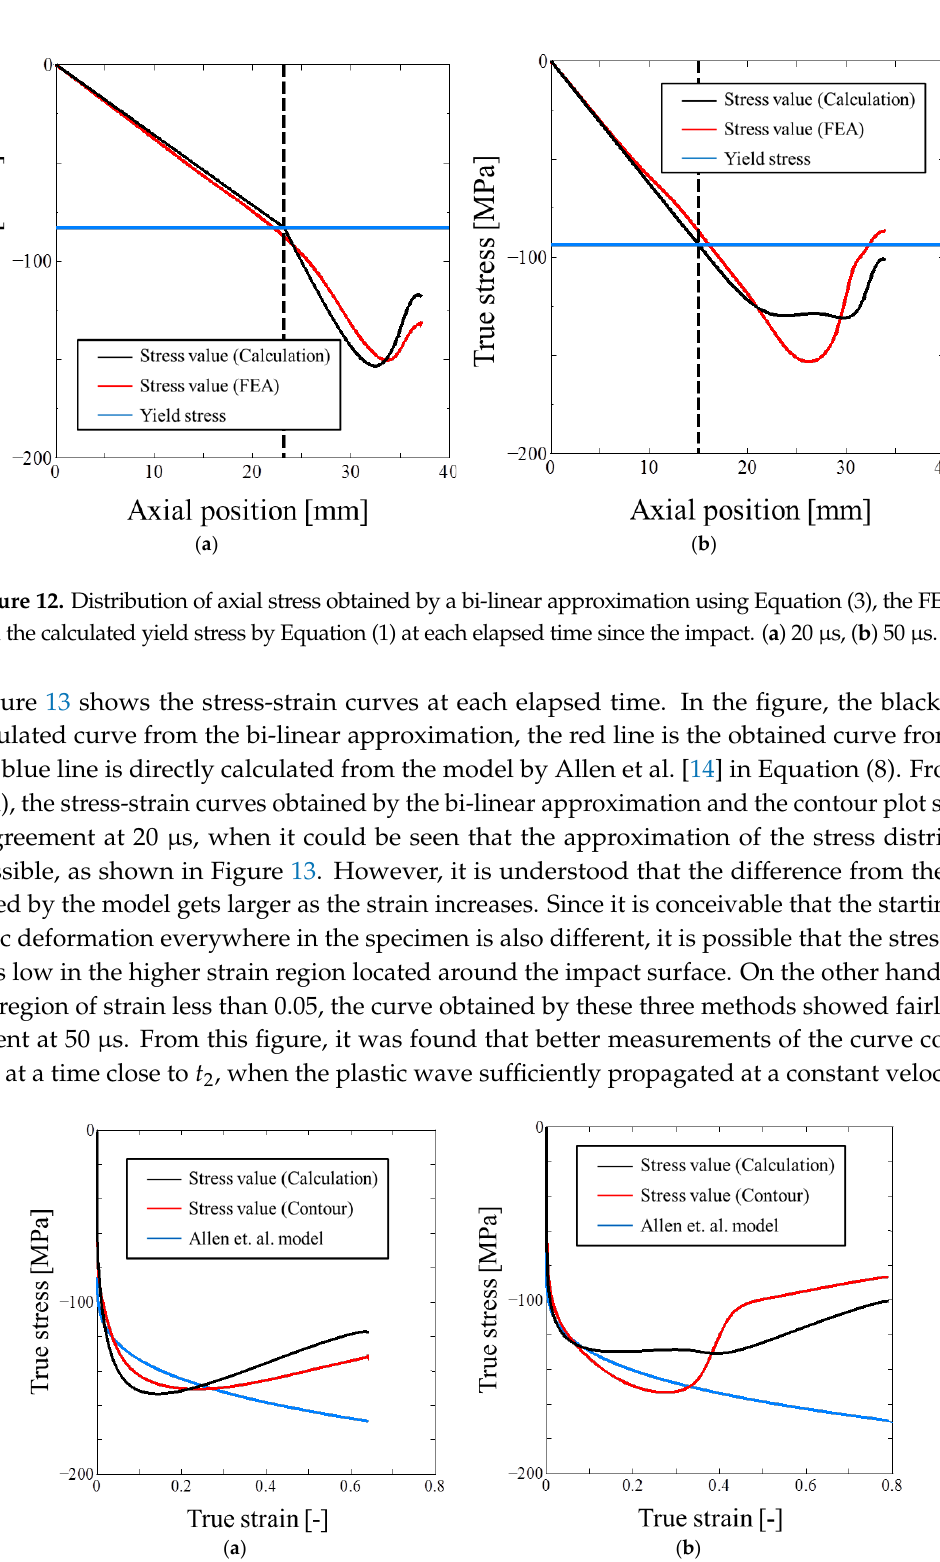
Figure 11. Distribution of the true strain obtained by Equation (4), a contour as a result of FEA and average of strain at each elapsed time. ( a ) 20 μs; ( b ) 50 μs.